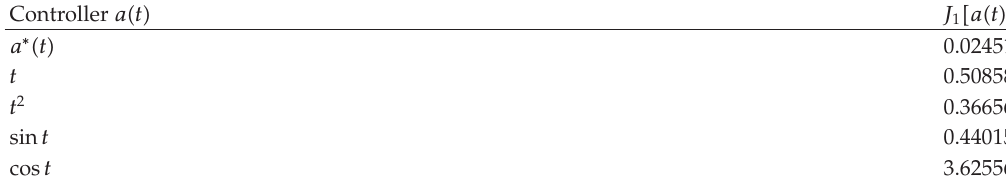
Table 1: Comparison between uncontrolled and controlled performance